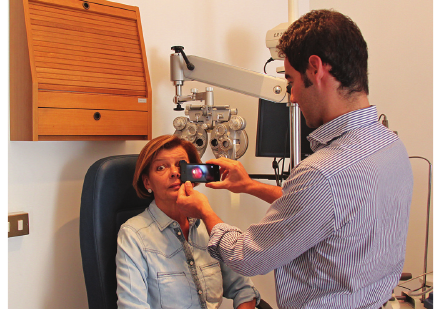
Figure 3: The acquisition procedure is similar to traditional direct ophthalmoscopy, but the examiner can work from a comfortable